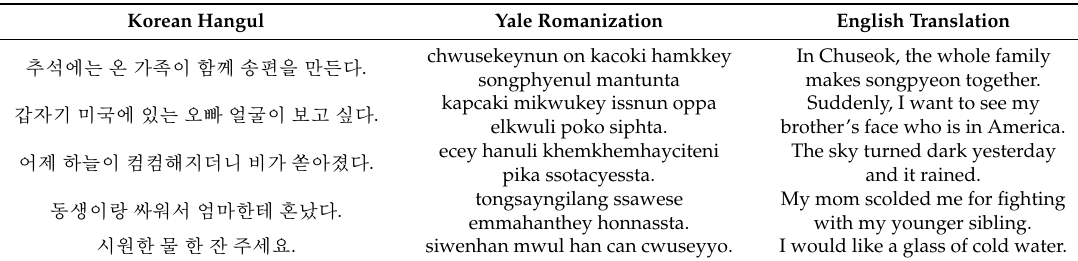
Table A2. Continuous speech stimuli recorded for the QoLT